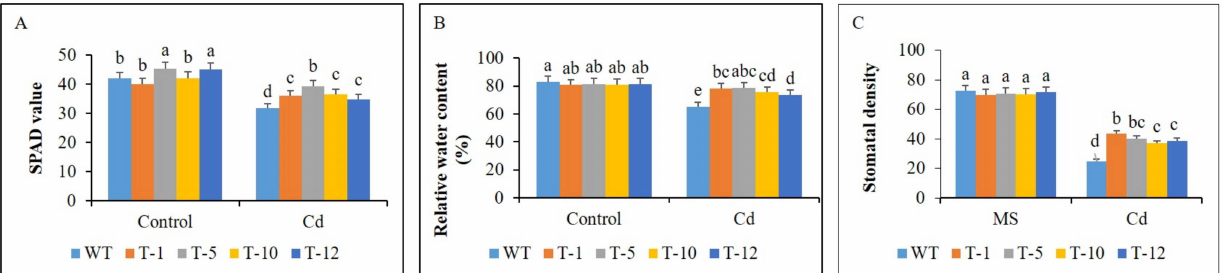
Figure 5. Comparison of plant physiological traits ( A – C ) in WT and transgenic petunia cv. ‘Mirage Rose’ plants under control and cadmium (Cd) stress condition. Data were collected on the 30th day of the experiment. Data represent the means of three replicates, and error bars indicate standard error. Means with the same letters are not significantly different by least significant difference test (LSDT, p <